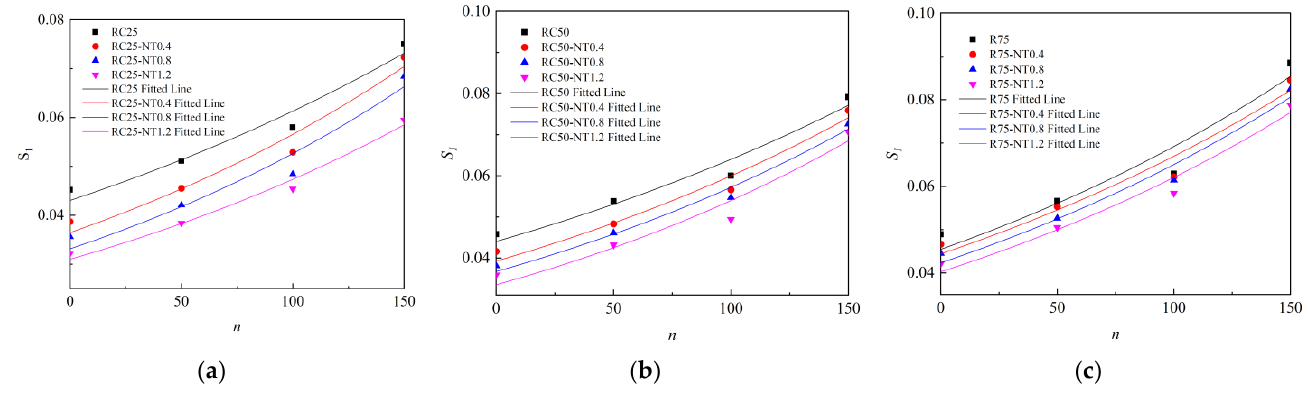
Figure 11. Fitted graph of water absorption S 1 . ( a ) R25 group; ( b ) R50 group; ( c ) R75 group.